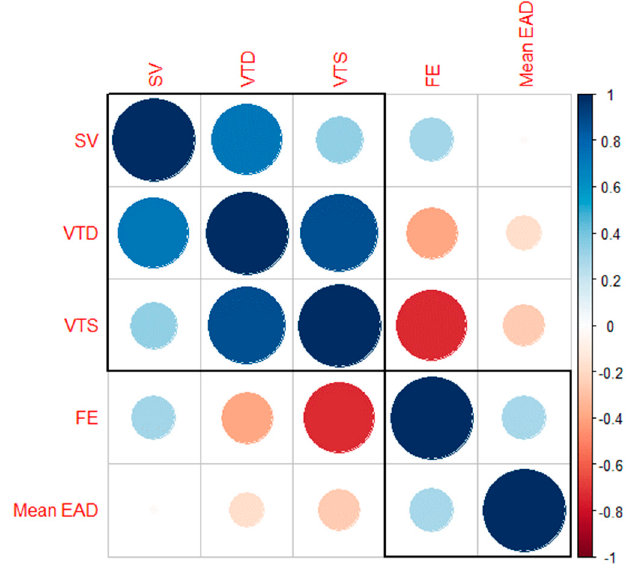
Figure 3. Correlogram showing correlation between variables.